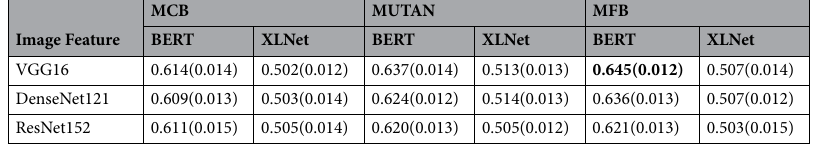
Table 8. Accuracy scores for the ablation study experiments of PathVQA yes-no answer type dataset.